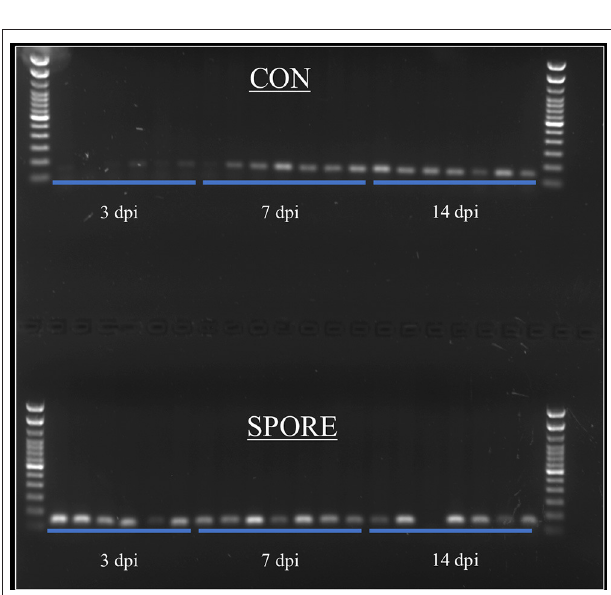
FIGURE 4 | SFB detection in ceca content via PCR. SFB-specific primers were used to detect SFB in ceca content at 3, 7, and 14 dpi time